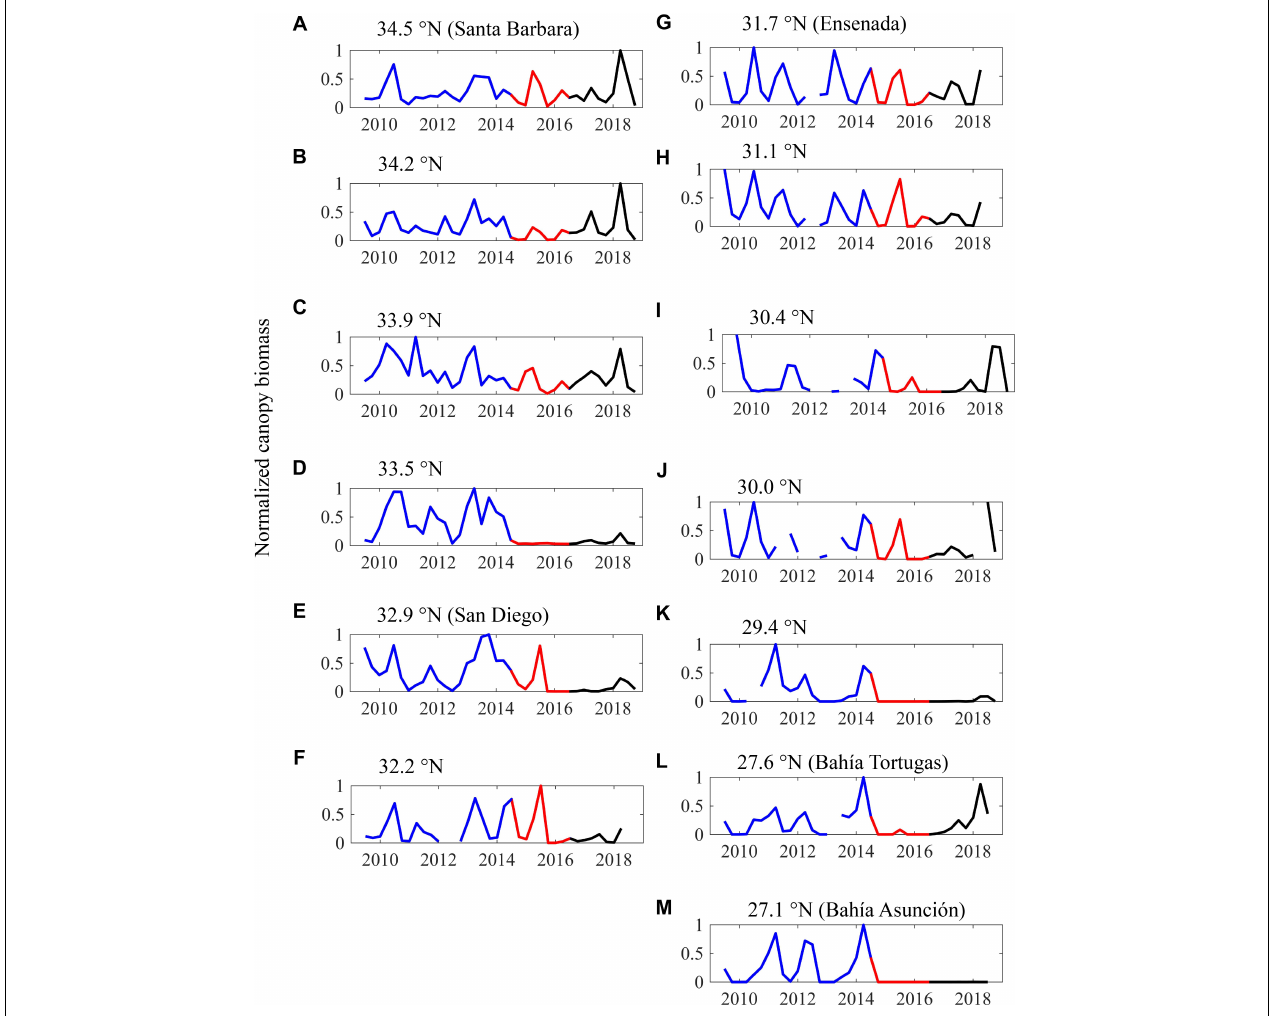
FIGURE 5 | (A–M) Time series of seasonal giant kelp canopy biomass from 2009 to 2018 for the thirteen 100 km coastline segments. Biomass is normalized to the maximum biomass observed in a segment over the time series. The baseline period (July 2009–June 2014) is shown in blue, the heat wave period (July 2014–June 2016) is shown in red, and the recovery period (July 2016–December 2018) is shown in